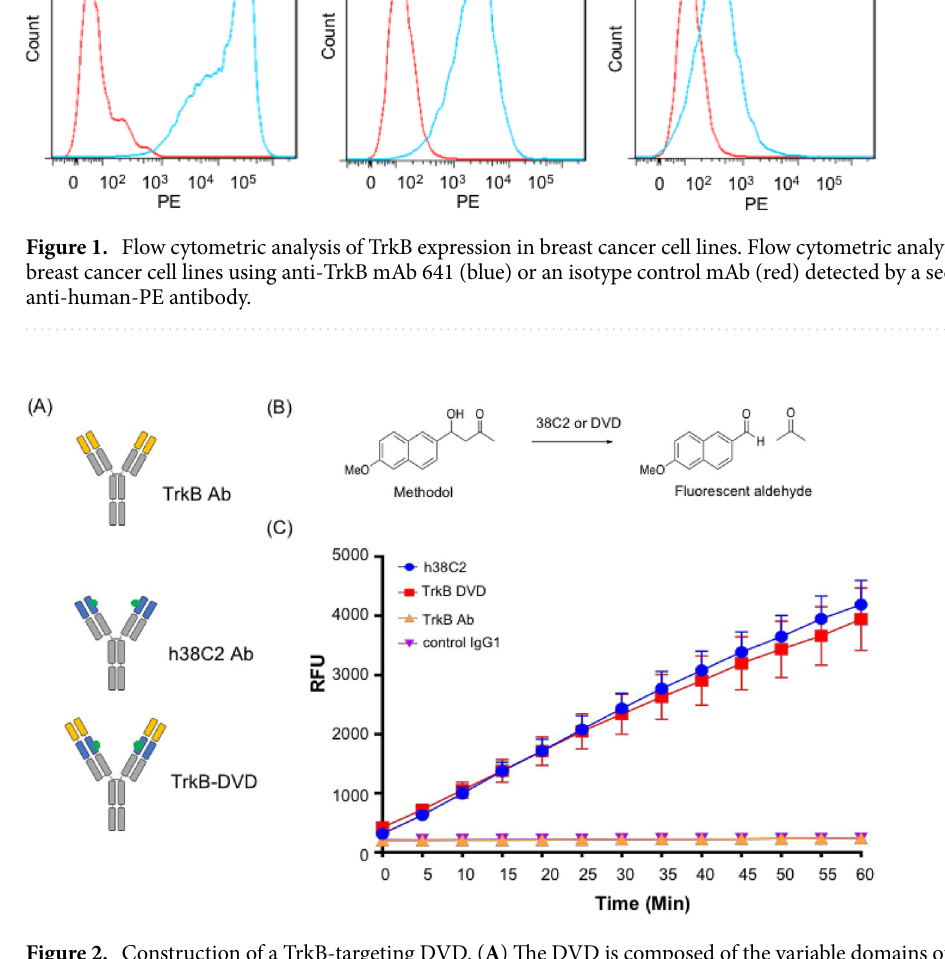
Figure 2. Construction of a TrkB-targeting DVD. ( A ) The DVD is composed of the variable domains of anti-TrkB mAb 641 (yellow), catalytic antibody h38C2 (blue) with its reactive Lys99 residue (green circle), and constant domains (gray). A short hexapeptide linker (ASTKGP) was used between the variable domains. ( B ) Structure of methodol and its parent fluorescent aldehyde and acetone following a retro-aldol reaction catalyzed by h38C2 or DVD. ( C ) The catalytic retro-aldol activity was measured using methodol as a substrate. The signal is reported in relative fluorescent units (RFU; mean ± SD of triplicates). Anti-TrkB and an isotype control IgG1 were used as negative controls. Abbreviation: dual variable domain (DVD), relative fluorescence units